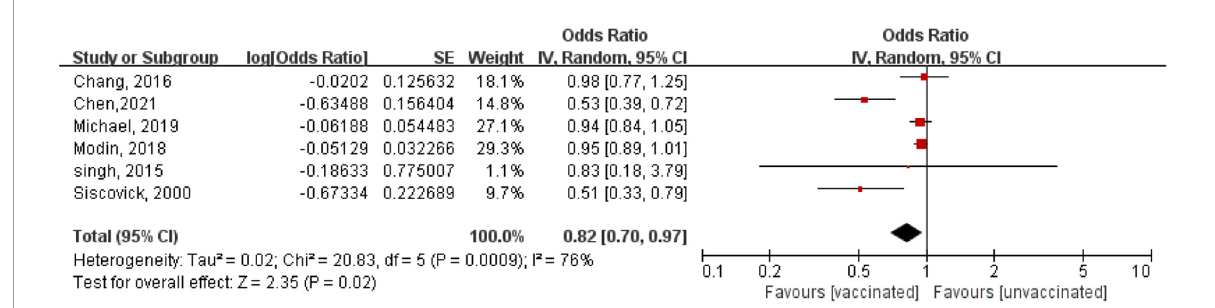
FIGURE2 Forest plot for the association between influenza vaccination and the risk of arrhythmia. The diamond indicates the pooled estimate. Red boxes are relative to study size, and the black vertical lines indicate the 95% CIs around the effect size estimate.